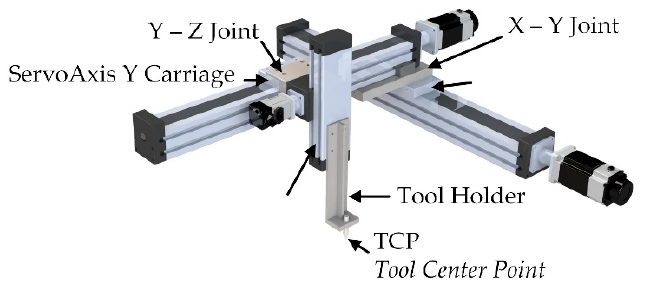
Figure 10. 3D representation of the Cartesian system of the example.